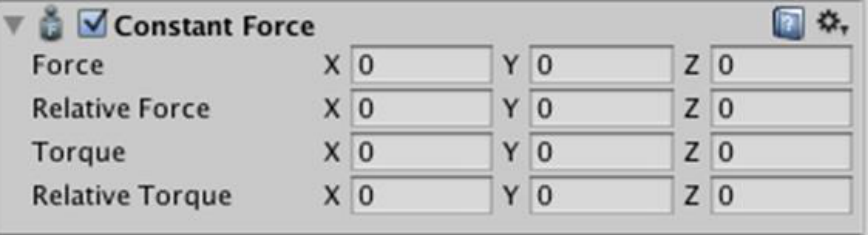
Figure 22. “ Constant Force ” component.